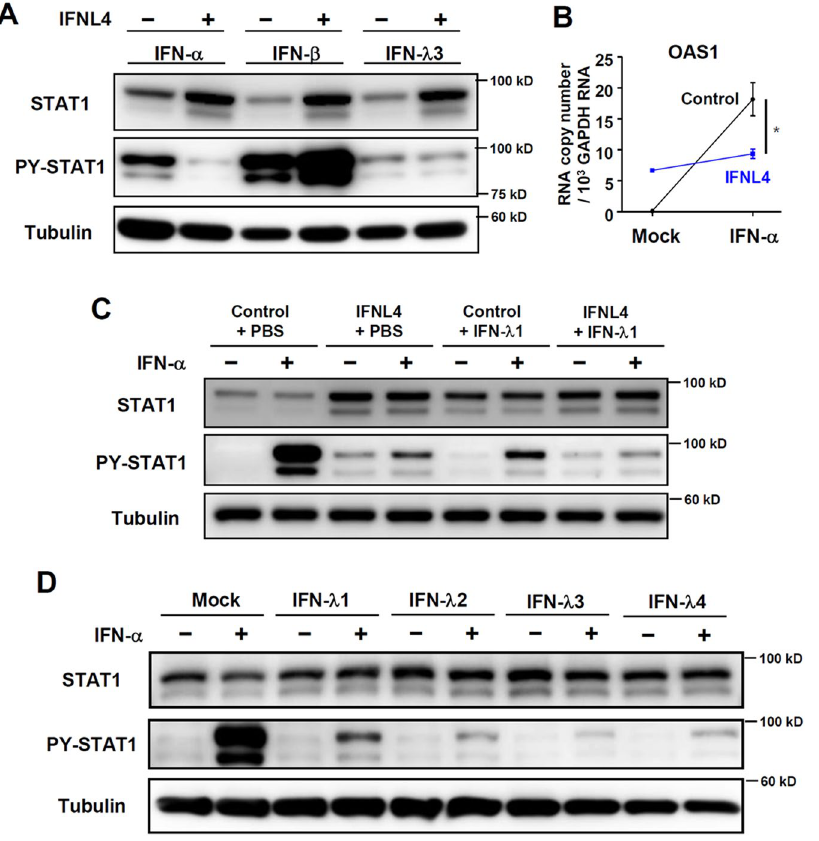
Figure 4. Cells that overexpress IFN- λ 4 or treated with IFN- λ 4 show weaker responses to IFN- α treatment. ( A , B ) Huh-7 cells were transfected with control or IFN- λ 4-expressing plasmids. After 96 hours, the cells were treated with 100 IU IFN- α , 1 ng/mL IFN- β , or 100 ng/mL IFN- λ 3. The cells were harvested after 15 minutes, and protein expression was analysed by immunoblotting ( A ), or the cells were harvested after 6 hours, and gene expression was analysed by real-time qPCR ( B ). Data are presented as means ± S. E. M. * P ≤ 0.05, *** P ≤ 0.001 (Student’s t-test). ( C ) Huh-7 cells were transfected with control or IFN- λ 4-expressing plasmids. After 24 hours, the transfected cells were treated with PBS or IFN- λ 1 (10 ng/ml). After 48 hours, the cells were treated with 100 IU IFN- α for 15 minutes. The cells were harvested, and protein expression was analysed by immunoblotting. All the data are representative of two independent experiments. ( D ) Huh-7 cells were treated with mock or 10 ng/mL recombinant IFN- λ 1, 2, 3, or 4. After 72 hours, the cells were treated with 100 IU IFN- α . The cells were harvested after 30 minutes, and protein expression was analysed by immunoblotting. All the data are representative of two independent